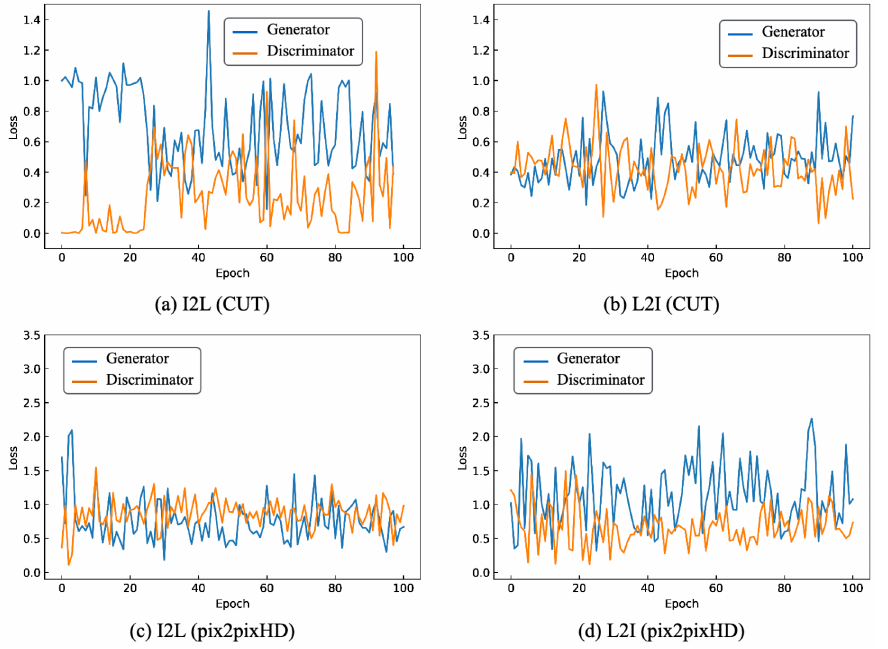
Figure 9. Time-series training loss trends for respective GANs in Rice